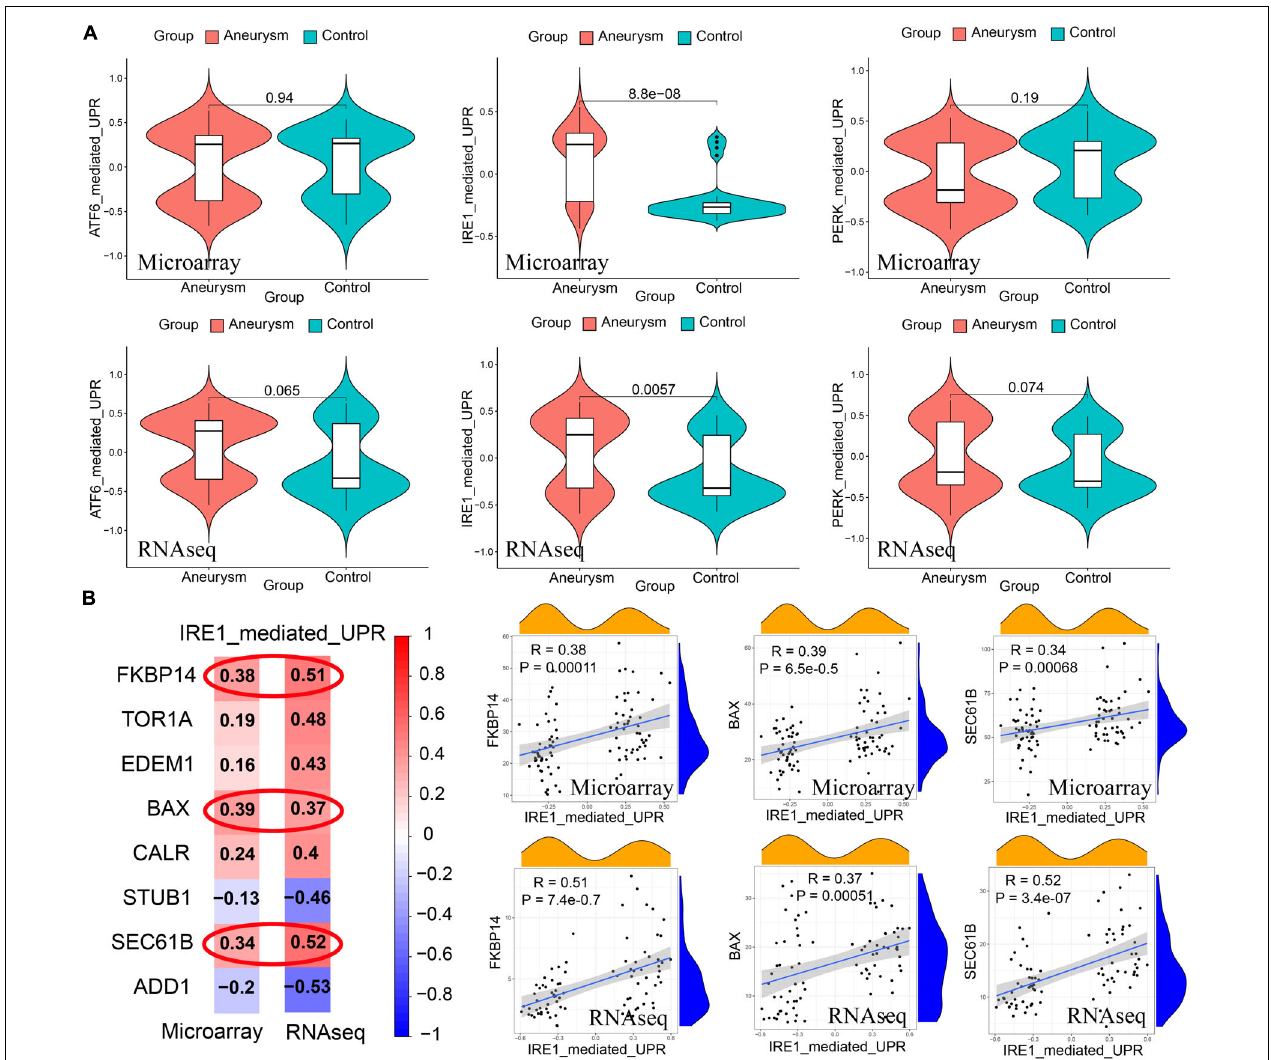
FIGURE 5 | Identification of ERS-related signaling pathways in both training and validating cohorts. (A) GSVA scores of 3 pathway expression. IRE1 pathway had a higher expression level in IAs than the level in controls. The expression of the ATF6 pathway and PERK pathway did not show significant differences between the two groups. (B) Pearson correlation between IRE1 pathway and signature genes. The expression of FKBP14, BAX, and SEC61B had high correlations to IRE1 pathway expression (Correlation coefficient > 0.3 in both training and validating